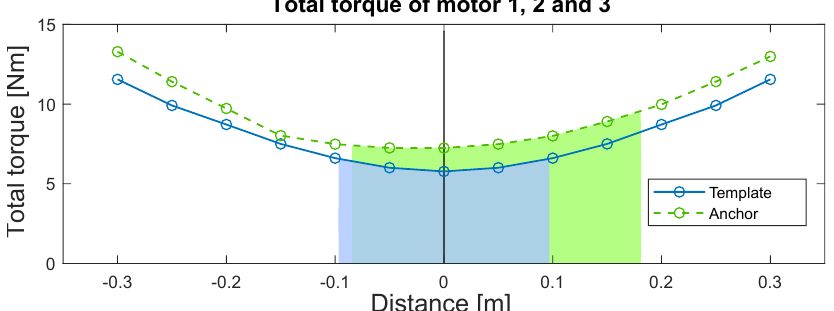
Figure 11. The total torque for all three motors used by the template and anchor morphology in the positions of Figure 10. The filled areas represent the lengths the legs could reach before one of their motors became theoretically